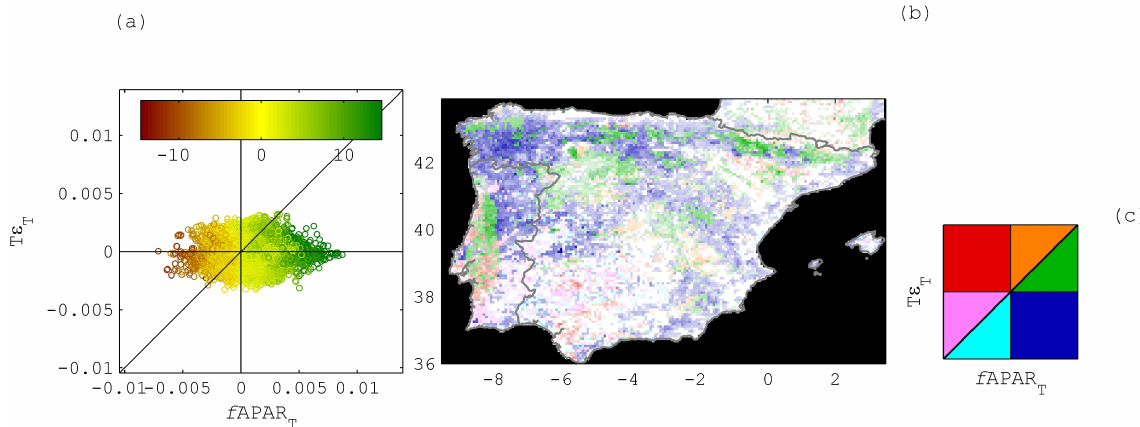
Fig. 10. Decomposition of NPP D trends (gCm − 2 yr − 2 ) into T ε and f APAR trends, T ε square meter per year) (a) . The spatial distribution of the underlying T ε colour-coding each NPP D according to its position in (a) following the diagram in (c) . The colour intensity in (b) is proportional to the T magnitude of NPP D . T